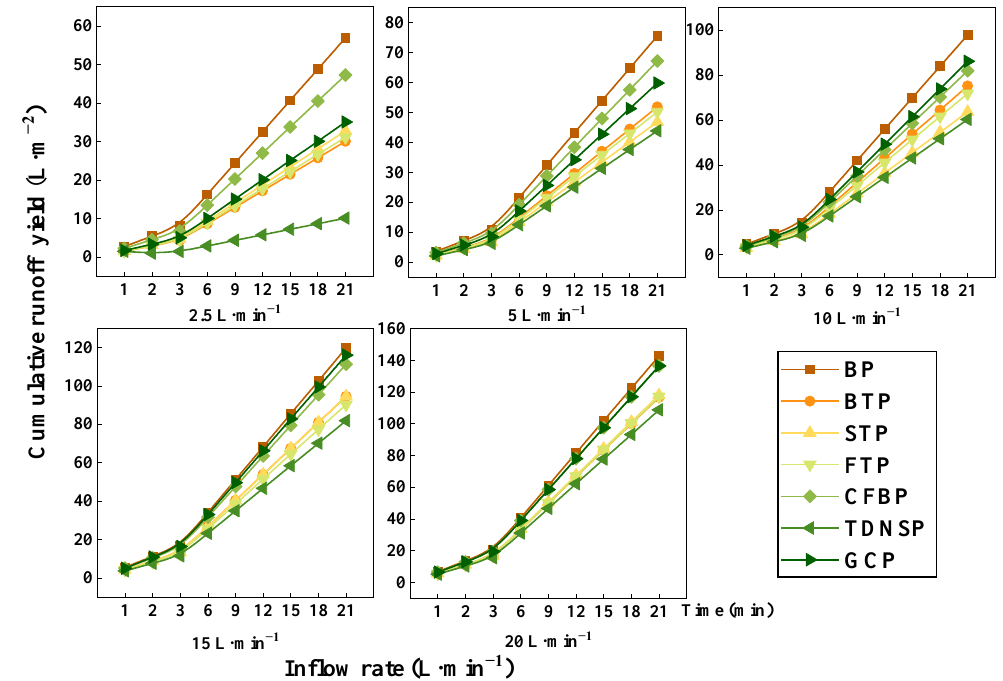
Figure 8. Cumulative runoff of seven measures under different inflow times.